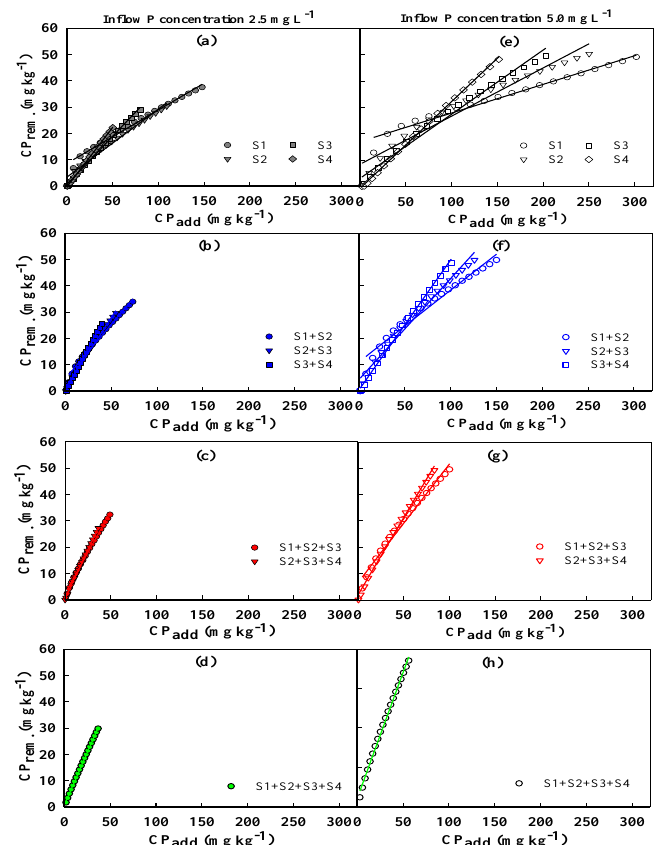
Figure 4. Cumulative phosphorus (P) removal (CP rem ) expressed as a function of cumulative P added (CP add ) for each individual slag segment and combination of successive segments. ( a – d ) are the single, double, triple, and quadruple segments for the inflow P treatment of 2.5 mg L − 1 , respectively. ( e – h ) are the single, double, triple, and quadruple segments for the inflow P treatment of 5.0 mg L − 1 , respectively.